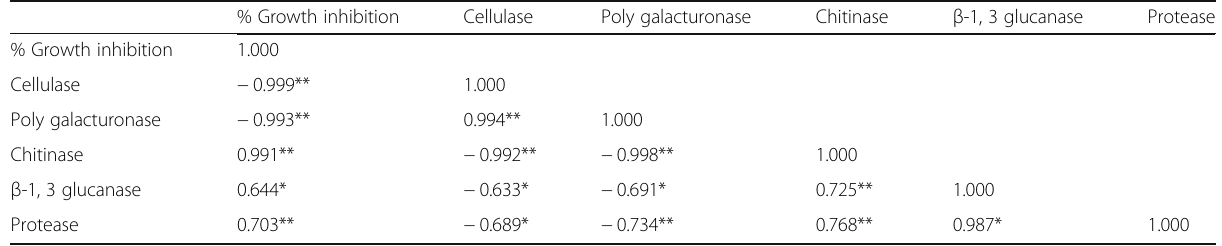
Table 1 Correlation matrix between growth inhibitions of Fusarium oxysporum f. sp. cumini ( Foc ) and production of lytic enzymes during in vitro antagonism with Pseudomonas fluorescens ( Pf ) isolates in the culture medium at 6 days after inoculation (DAI) % Growth inhibition Cellulase Poly galacturonase Chitinase β -1, 3 glucanase